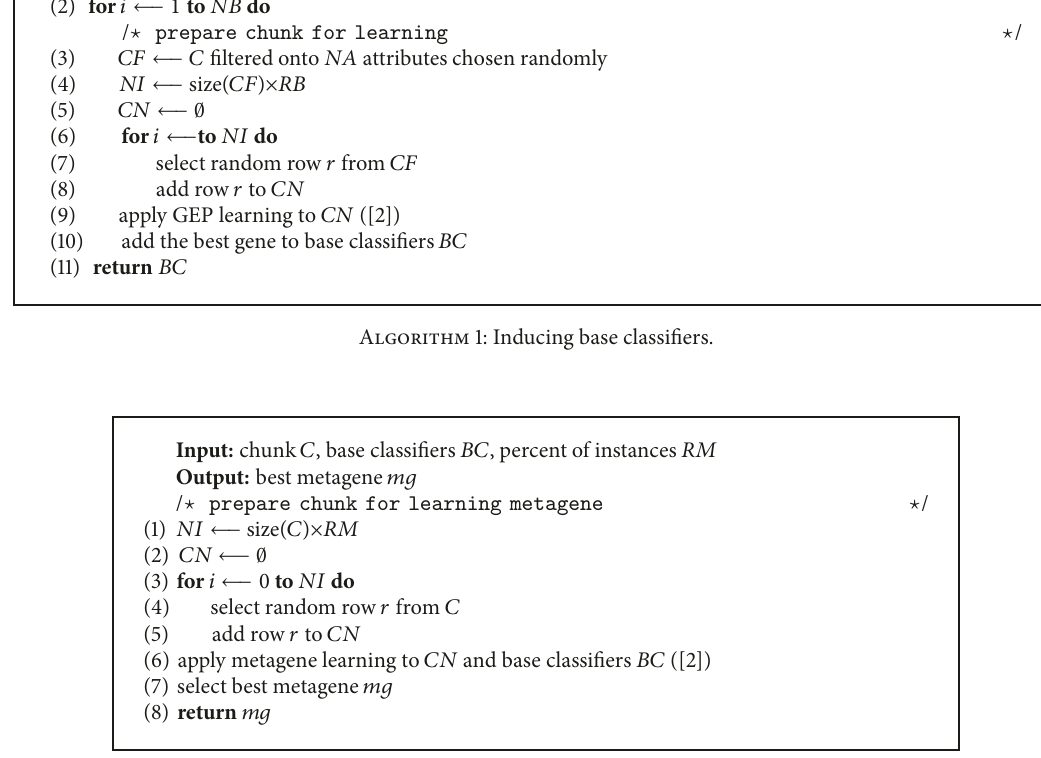
Algorithm 2: Inducing